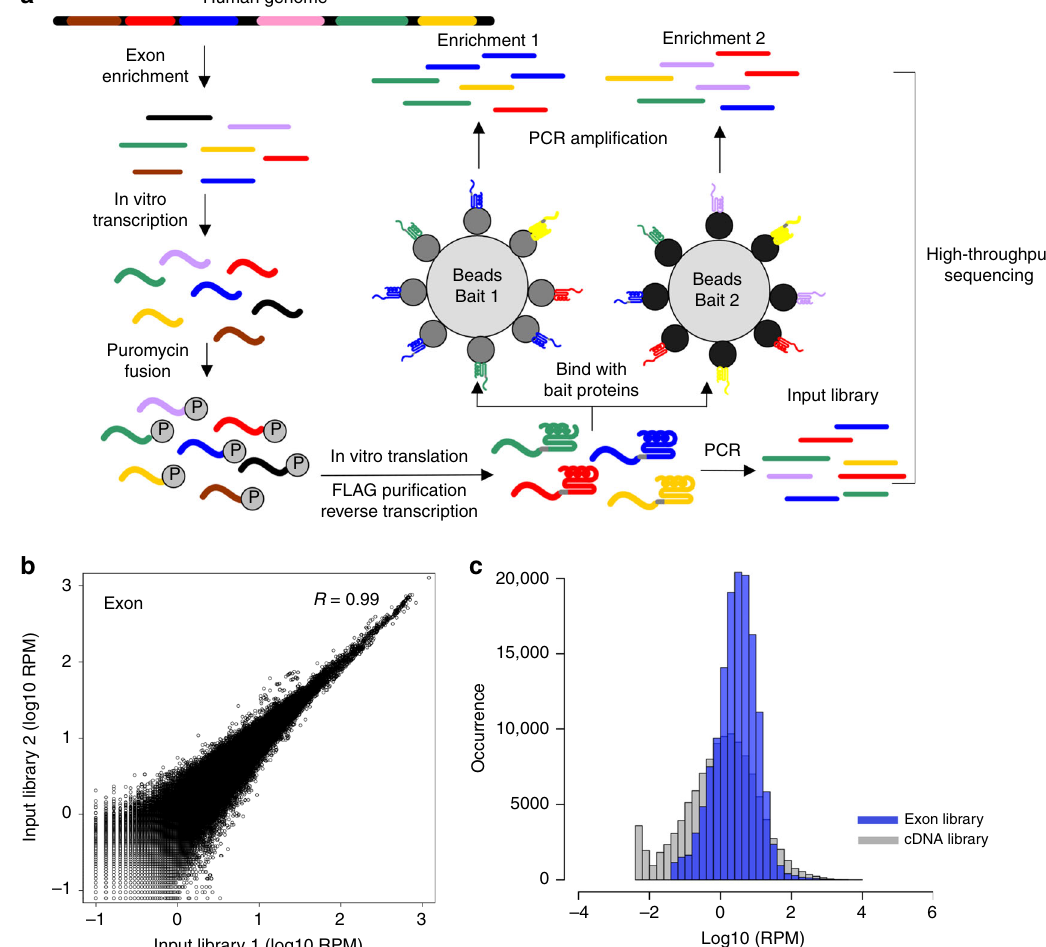
Fig. 1 Development of md-LED to detect protein – protein interactions. a The schematic diagram shows the experimental design of md-LED. Human exons library was enriched from fragmented DNA. The DNA fragments were transcribed in vitro and translated. Puromycin was utilized to link mRNA to its encoded protein. The nuclear acid and protein fusion complexes were pre-selected using C-terminus FLAG-tag as an input library. The pre-selected input library was then selected against bait proteins and subjected to high-throughput sequencing to determine the identity and frequency of each exon. b Scatter plot shows the correlation between two independent input libraries. Exon frequencies, shown as reads per million (RPM) were calculated for each replicate and strong correlation were observed with biological duplicate. c The distribution of transcript frequency in input libraries is shown with histogram. Blue bars represent the distribution of exon library, and gray bars correspond to cDNA